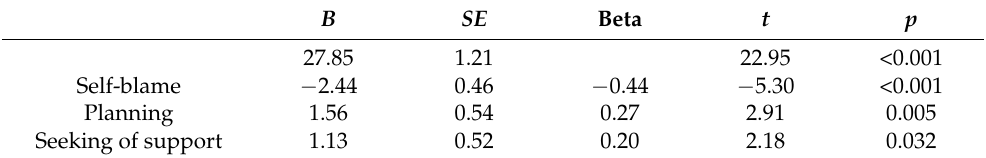
Table 6. Results of stepwise linear regression analysis for self-esteem level as the dependent variable. B SE Beta t p 27.85 1.21 22.95 <0.001 Self-blame − 2.44 0.46 − 0.44 − 5.30 <0.001 Planning 1.56 0.54 0.27 2.91 0.005 Seeking of support 1.13 0.52 0.20